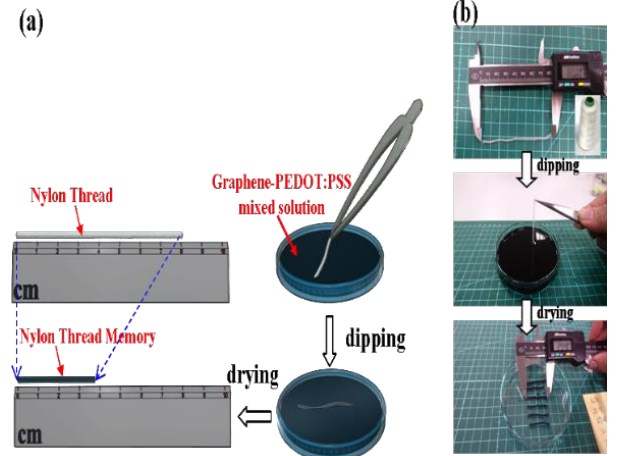
Figure 1. ( a ) Schematic of the simple two-step dip-and-dry solution process for the fabrication of the non-volatile nylon thread (NT) resistive memory. ( b ) An actual picture of the NT sample with the length reduction from 80 to 29.48 mm.